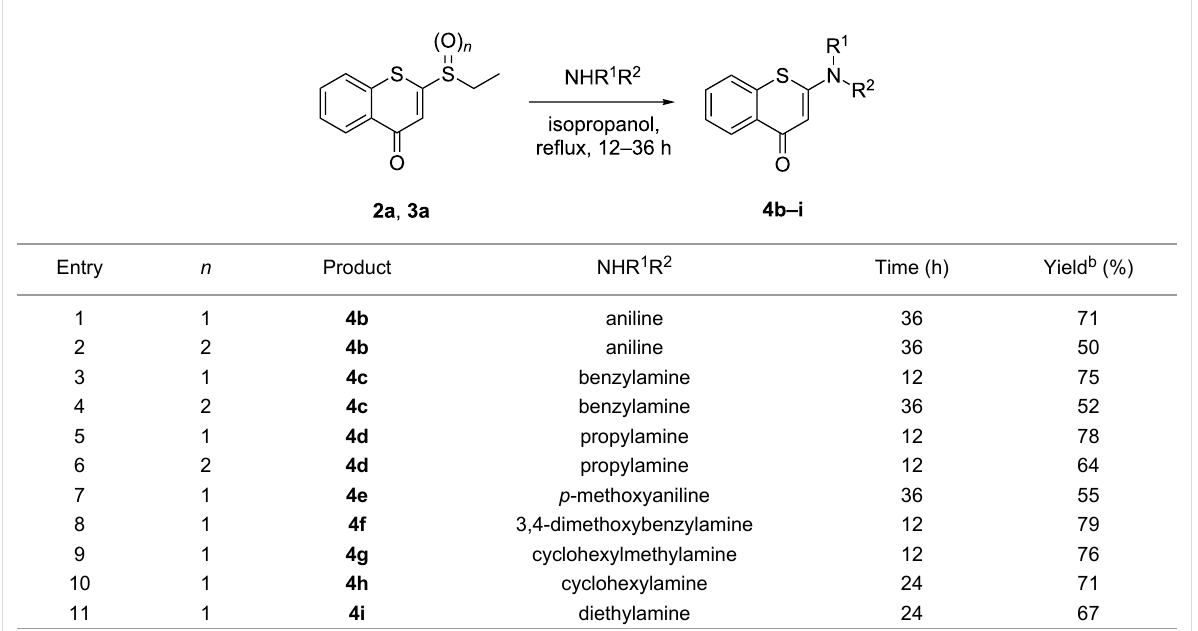
Table 2: Further confirmation of the sulfinyl/sulfonyl groups as optimal leaving groups.